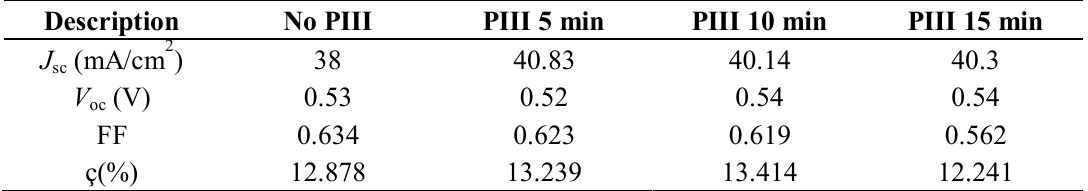
Table 3. Summary table of without PIII, PIII 2 KeV 5 min, PIII 2 KeV 10 min, and PIII 2 KeV 15 min homojunction samples without AlO x